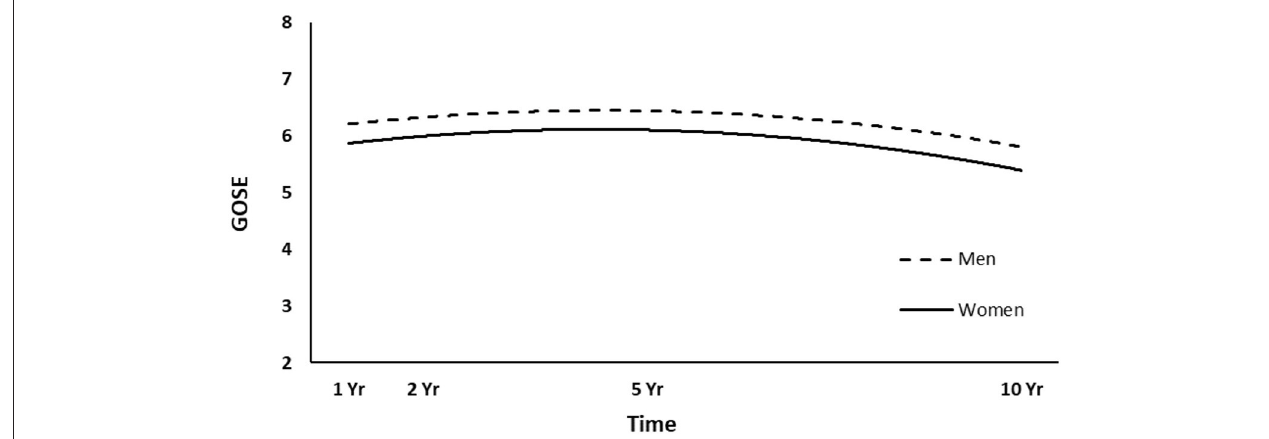
FIGURE 2 | Main effect of sex on GOSE